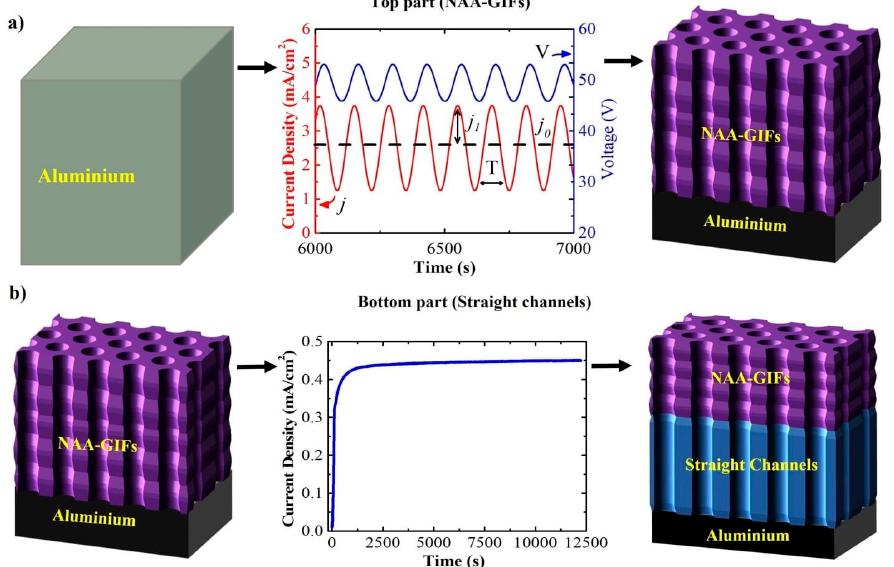
Figure 1. Schematic diagram of the electrochemical approach applied to prepare Hy-NAA-GIFs. ( a ) represents a sinusoidal current density anodization profile j and V to obtain the modulated on the top part of the structure., j 1 is the measured cell current density for the amplitude of sinusoidal variations and j 0 represents the offset current density, T depicts the time period of the process; ( b ) shows the constant potential anodization process to obtain the straight channels at the bottom.